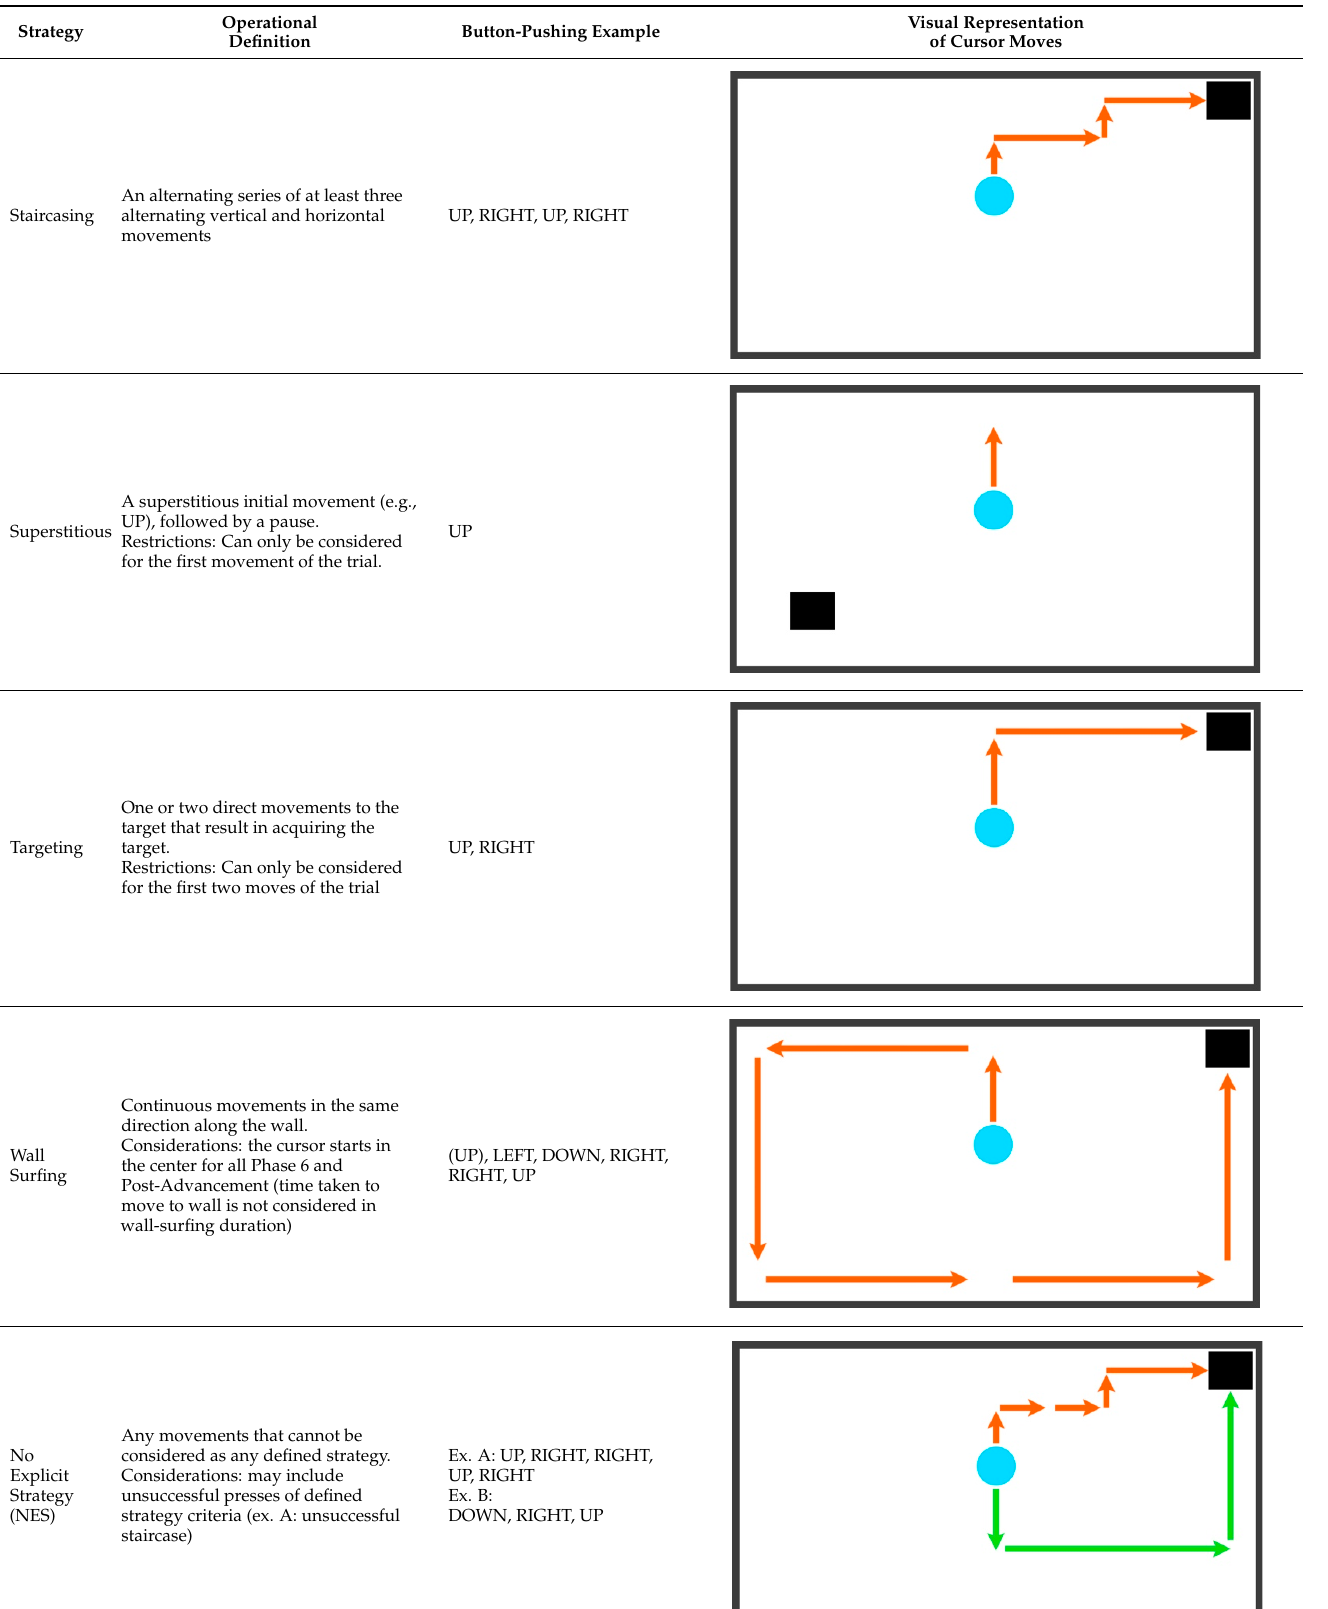
8 Table 1. Focal strategies, operational definitions, and visual examples. Strategy